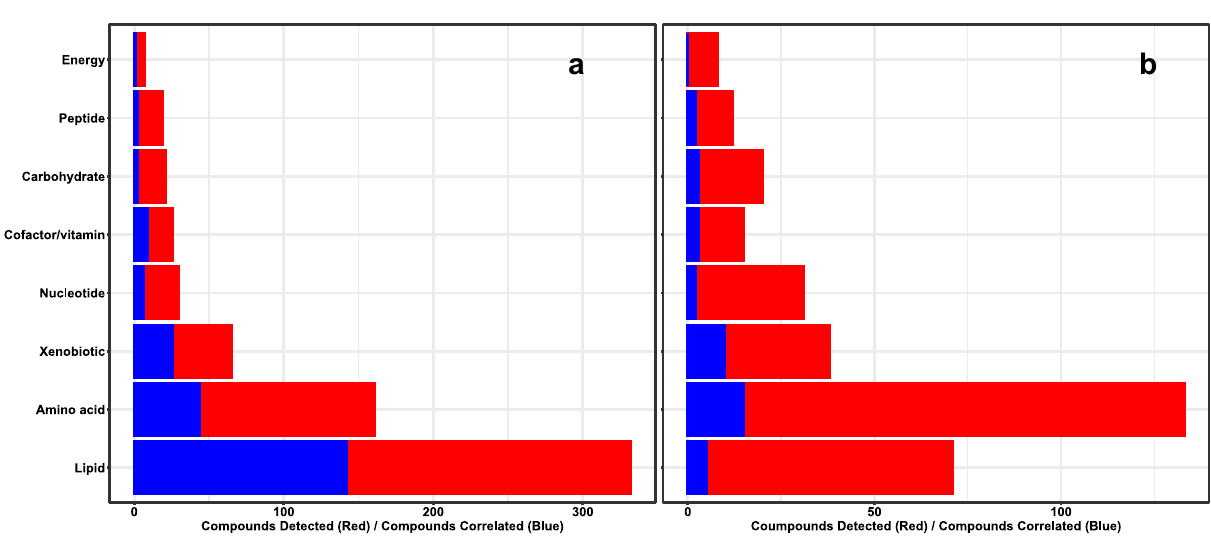
Figure 2. Number of compounds detected (red) and number significantly correlated after 5% false discovery rate adjustment in ( a ) plasma and marrow, and ( b ) plasma and